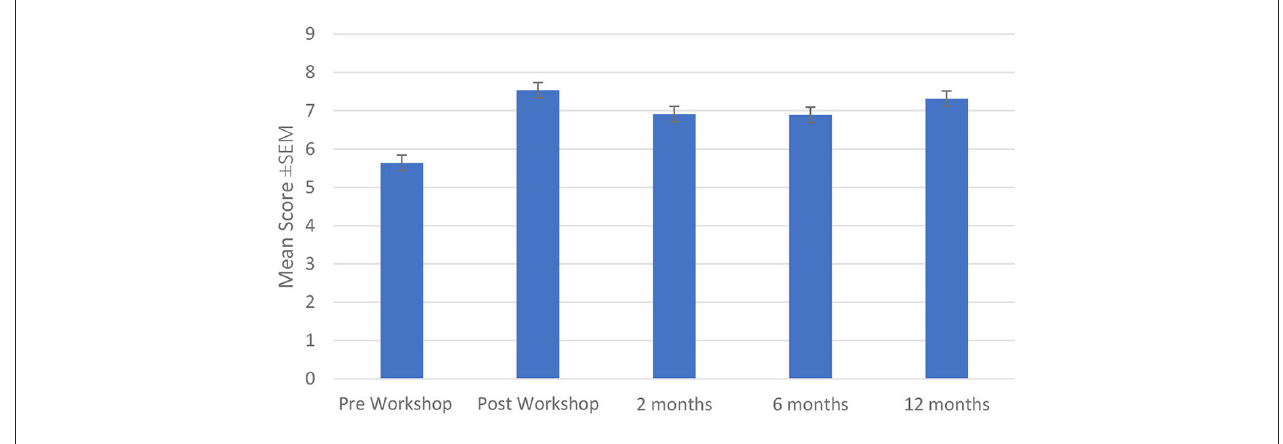
FIGURE 1 | Mean questionnaire scores.